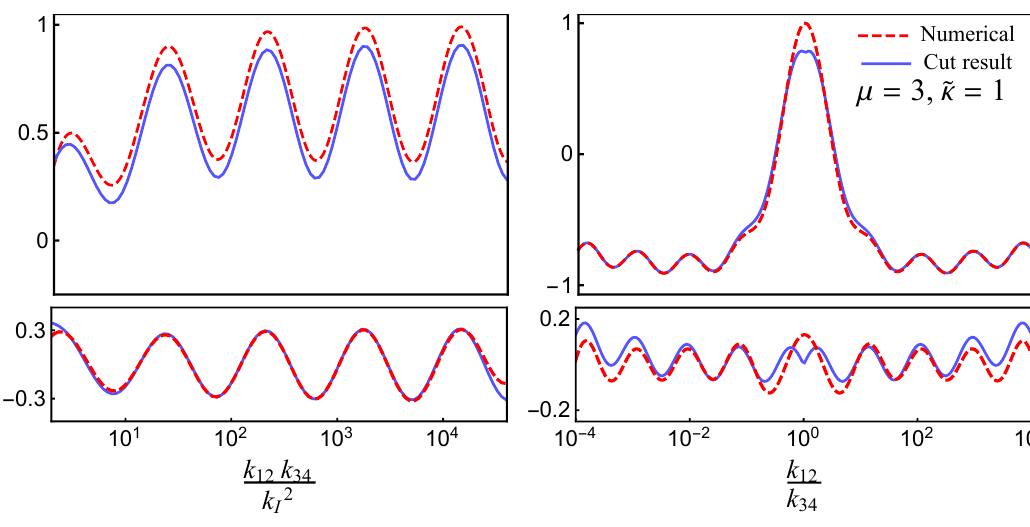
Figure 12 . The 4-point functions obtained from the cut rule (blue lines) and numerical integration (red dashed lines). Left panel: non-local type CC signals, where we have fixed k 12 /k 34 = 1 , and (cid:0) (cid:1) 9 / 2 multiplied a factor k 12 k 34 /k 2 for better visualization. Right panel: local type CC signals, I where we have fixed k 12 k 34 /k 2 = 4 × 10 4 . All results in the upper panels are normalized by their I maxima. In the lower panels, we compare the CC signals filtered from the numerical result and that directly obtained via the